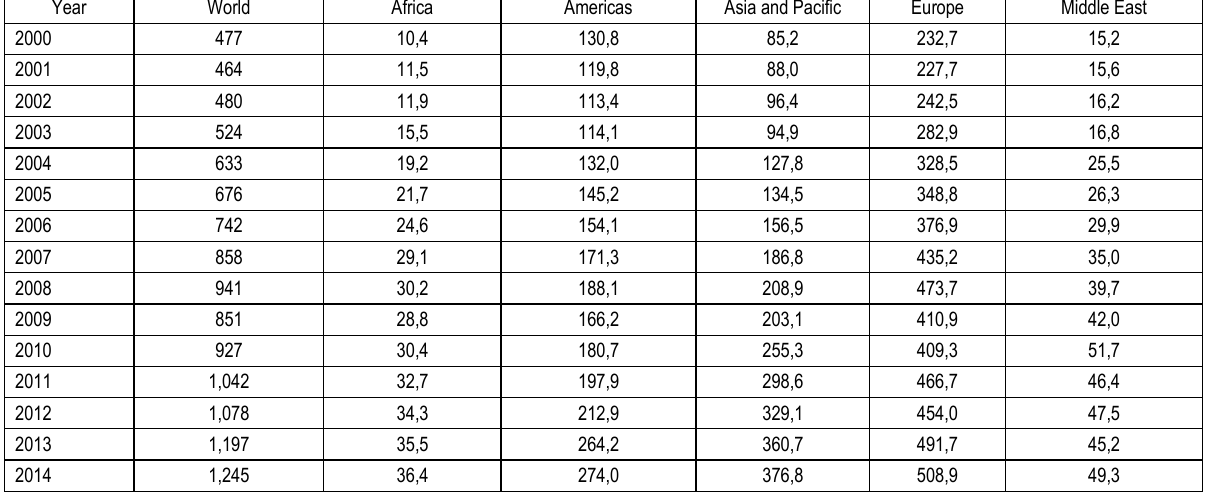
Table 2. International tourism receipts, billion